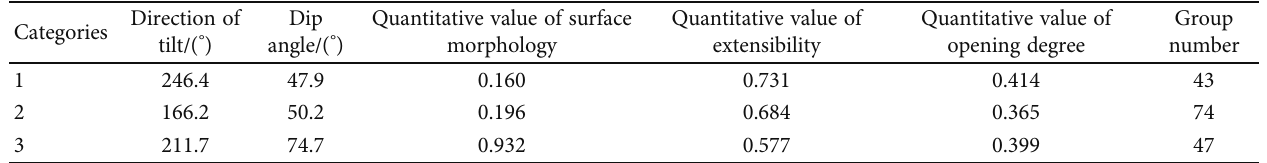
Figure 7: Diagrams of clustering validity grouping e ff ect. Table 4: Results of the FCM method for structural plane